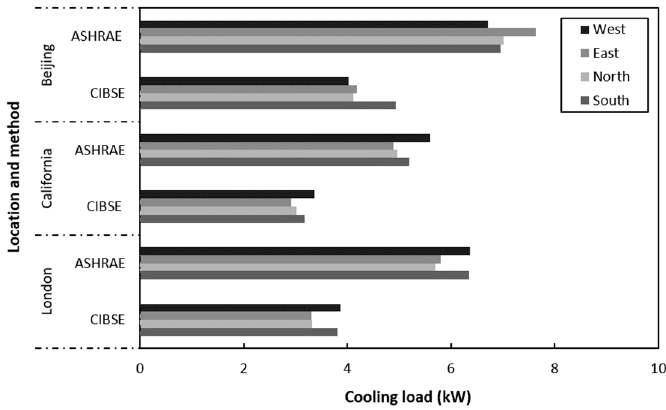
Figure 8. Orientation impacts on peak heat gains.